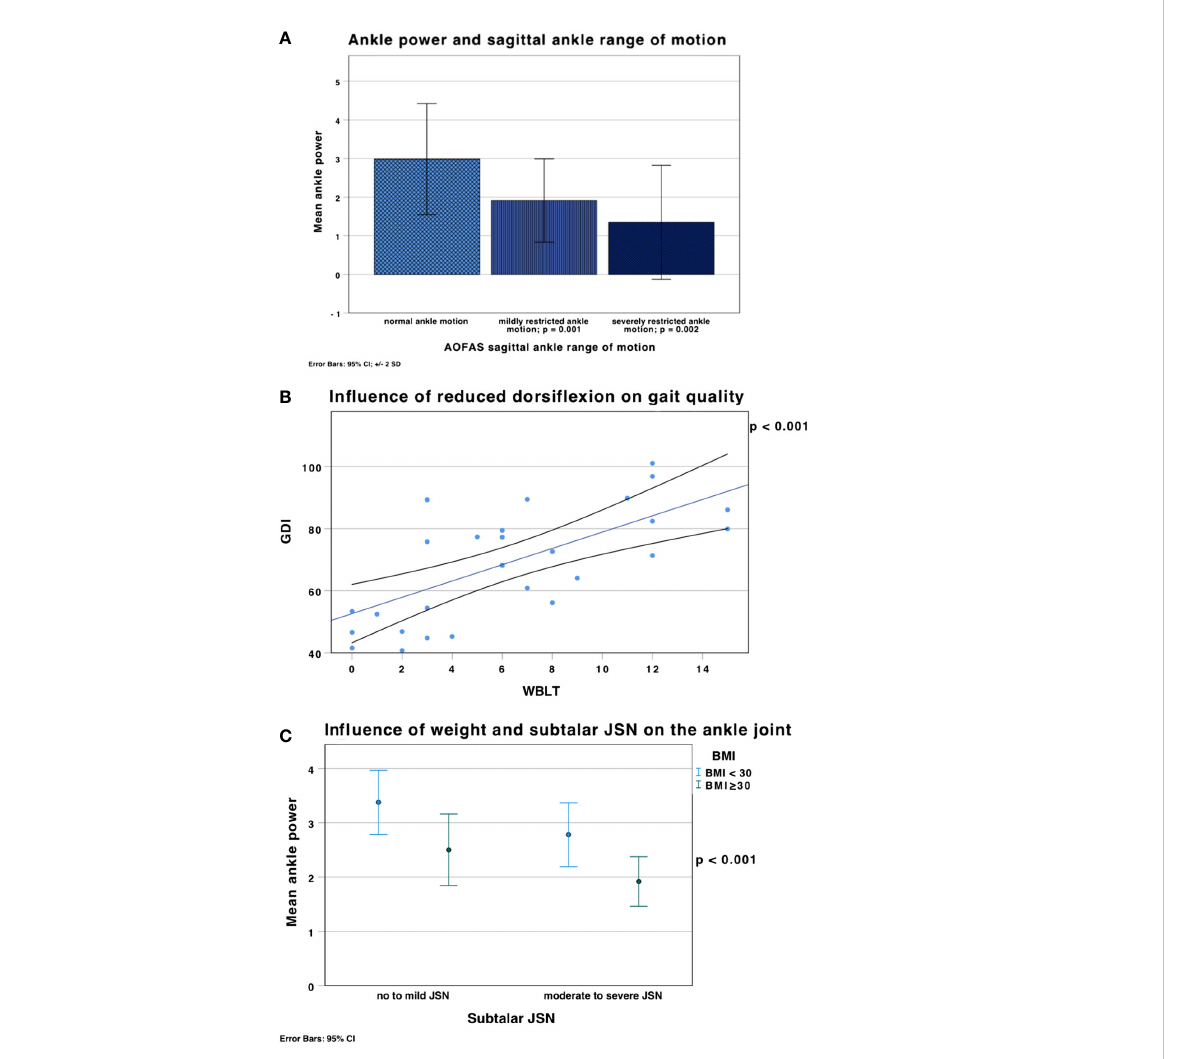
FIGURE 9 (A) Mean ankle power (error bars ± 2 SD) was signi fi cantly lower in ankles with mildly restricted sagittal ankle ROM in the AOFAS score (F(2,27) = 8.968, p = 0.001); ankle power was lower in patients with severely restricted ankle ROM (1.35 ± 0.74 W/kg; p = 0.002), which was de fi ned as ROM < 15°, compared to normal (2.85 ± 0.8 W/kg) or mildly restricted ankle motion (1.9 ± 0.5 W/kg). (B) Linear correlation between the GDI and the WBLT (weighted ankle dorsi fl exion). Reduced distance from the wall in the WBLT (= reduced ankle dorsi fl exion) (x axis) led to reduced gait quality (lower GDI) (y axis) (p < 0.001). (C) In fl uence of weight and subtalar JSN on ankle power shown in mean ± SD. Obesity (green), de fi ned as a BMI ≥ 30 kg/ m 2 , a higher BMI is associated with lower ankle power (p <